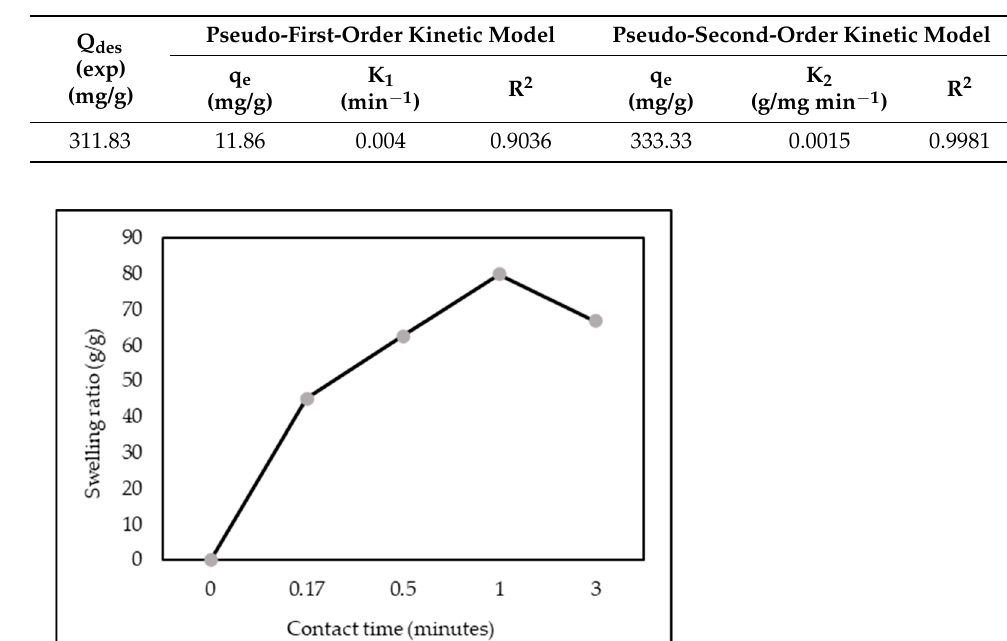
Figure 13. Linear desorption kinetics of AR88 from AR88 loaded ZL–CH hydrogel. ( a ) Pseudo-first- order kinetic model; ( b ) pseudo-second-order kinetic model. Table 4. Correlation and constant coefficients of pseudo-first-order and second-order kinetic models for the desorption of AR88 from AR88 loaded ZL–CH hydrogel.